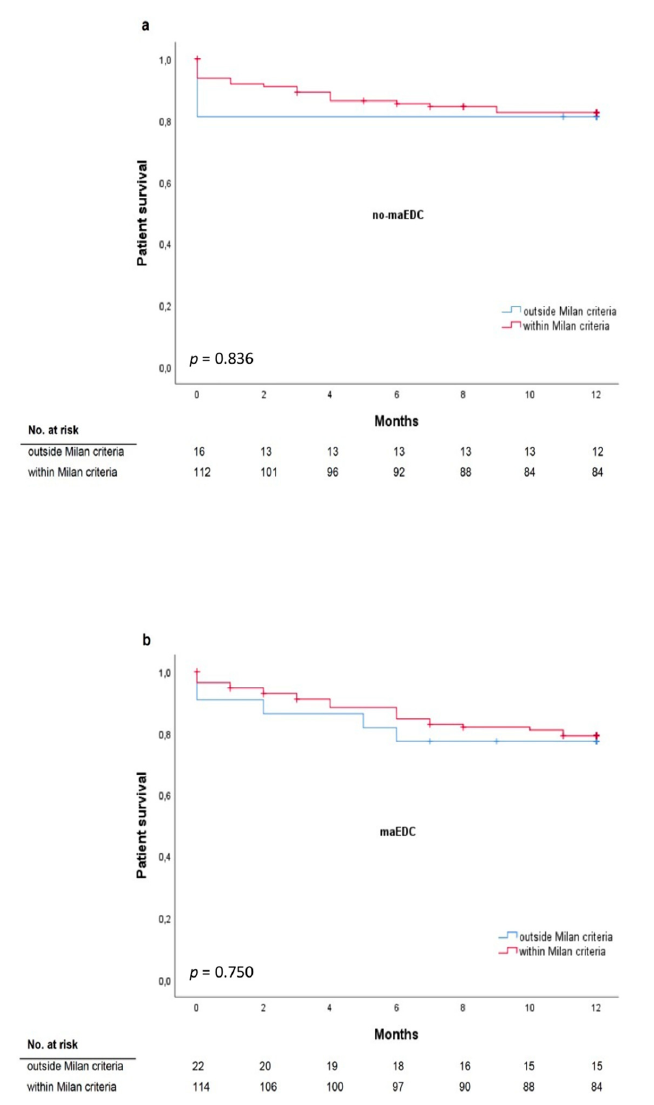
Figure 5. One-year survival for patients who met or did not meet the Milan criteria* transplanted with grafts without maEDC ( a ) (log-rank p = 0.836) and with maEDC ( b ) (log-rank p = 0.750). * All patients met the University of California San Francisco (UCSF) criteria